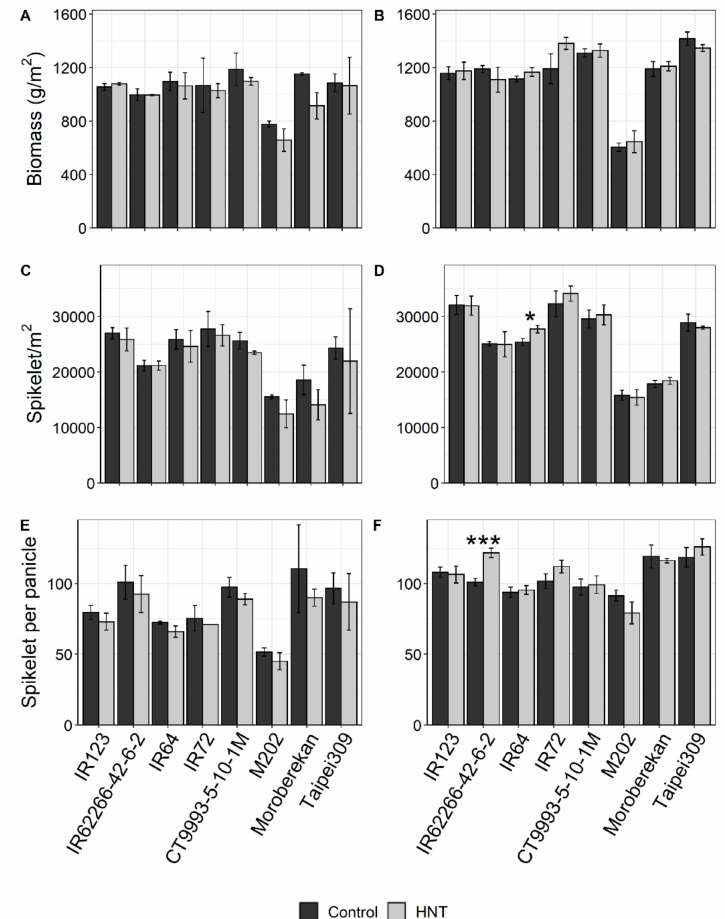
Figure A4. Biomass ( A , B ), spikelets per m 2 ( C , D ), and spikelets per panicle ( E , F ) of eight rice cultivars in response to HNT stress for the WS ( A , C , E ) and DS ( B , D , F ). For the WS, variance is displayed as range between means of two replicates with 12 plants each; for the DS, the standard error of the mean of five replicates with 12 plants each is shown. Cultivars are sorted alphabetically within the respective O. sativa subspecies indica (1-4) and japonica (5–8). Significance levels were only calculated for the DS due to the insu ffi cient replicate number in the WS and are indicated by asterisks: 0.001 < ***; 0.001 > ** < 0.01; 0.01 > * <